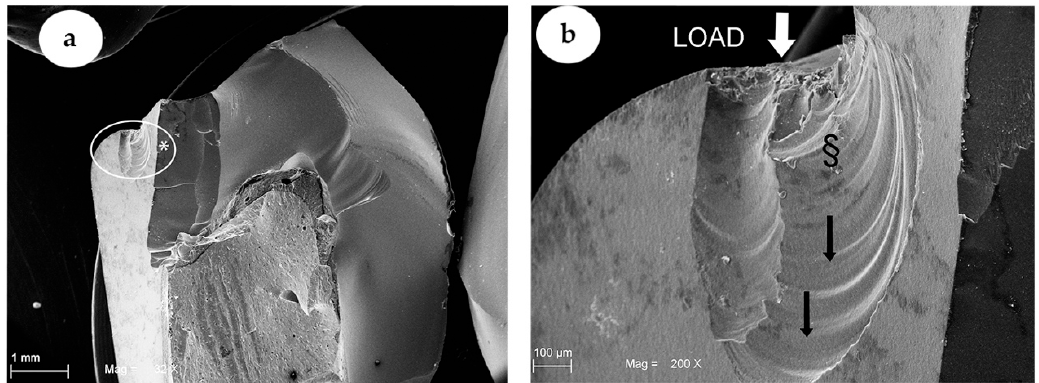
Figure 4. SEM images showing representative ZLS crown of ARC Group. In ( a ), (32 × magnification) the fracture of ZLS crown is shown. The * indicates area showed at a higher magnification. It is possible to see the abutment attached to the crown in ( b ) (200 × magnification). The white arrow shows the force application point. The § demonstrate the “mirror” areas near the point of load application. Moreover, a fracture surface with less “hackle” areas compared to GIC Group is shown, whilst the blackarrows indicated the direction of fracture propagation.